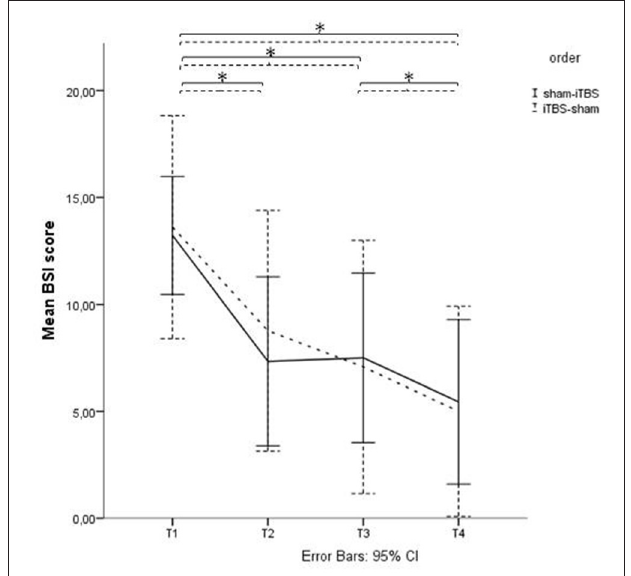
FIGURE 2 | Beck Scale of Suicide ideation (BSI) scores before and after active and sham treatment. Graphical representation of the BSI mean scores with Time (baseline (T1), after 1 week of stimulation (T2), after finishing the treatment protocol (T3) and 2 weeks later (T4)) as within-subjects variable, and Order (sham > active vs. active > sham) as between-subjects factor. ∗ Indicates significant difference.